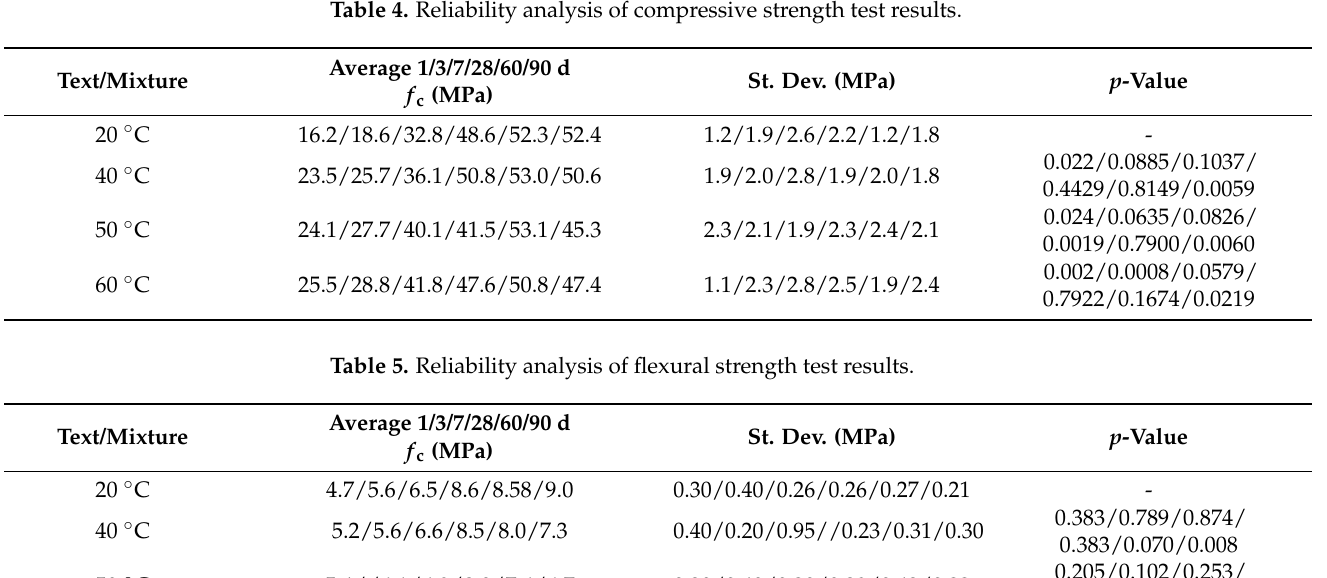
Table 4. Reliability analysis of compressive strength test results.